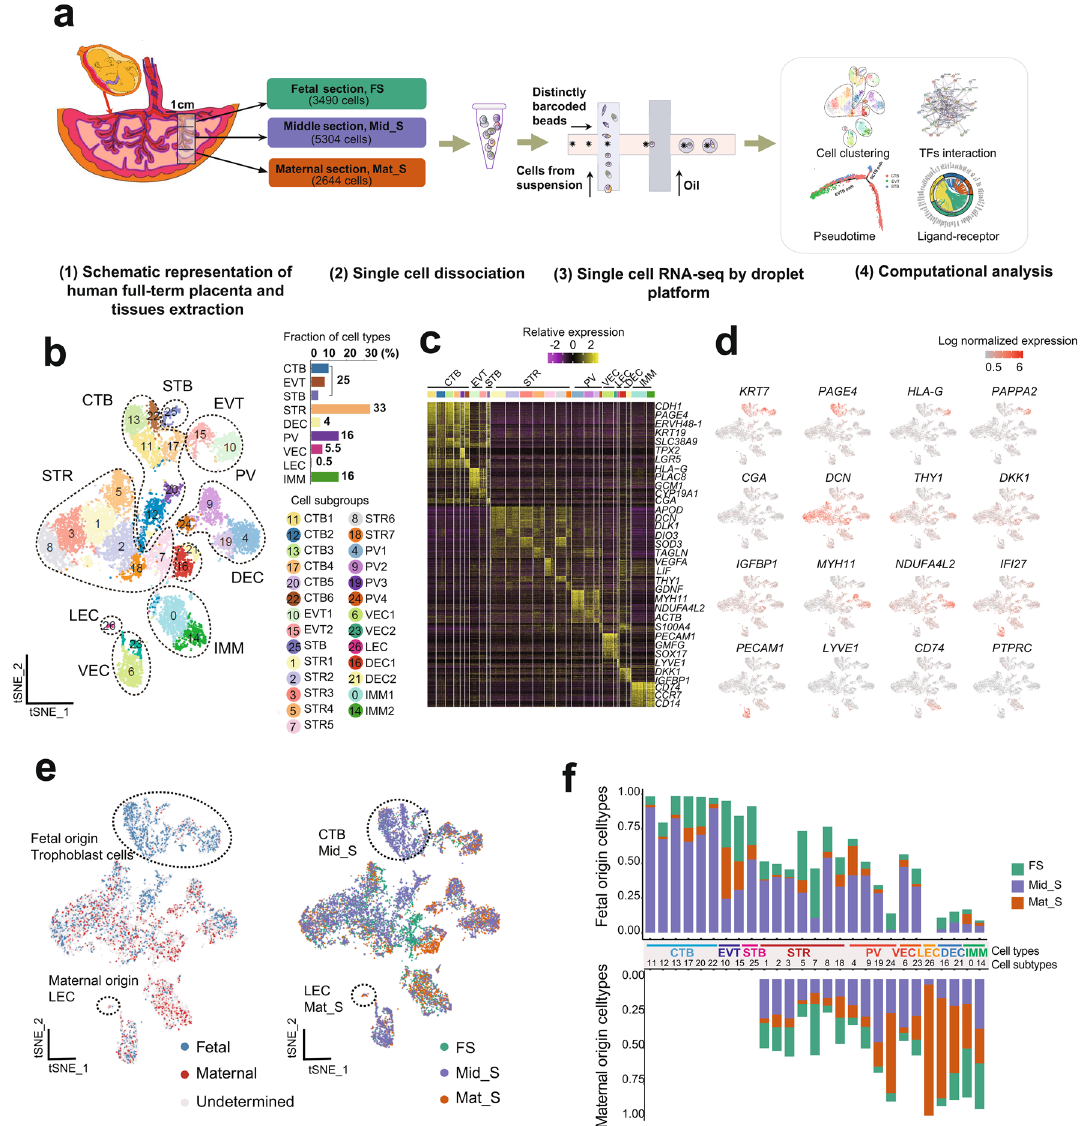
Figure 1. Dissecting cellular heterogeneity of human full-term placenta. ( a ) Workflow of single-cell transcriptome profiling of human full-term placenta. ( b ) T-distributed stochastic neighbor embedding (t-SNE) analysis of human full-term placenta (Left). Each dot represents an individual cell. Colors indicate cell type or state. PV, perivascular cell; STR, stromal cell; IMM, immune cell; CTB, villous cytotrophoblast; EVT, extravillous trophoblast; STB, syncytiotrophoblast; VEC, vascular endothelial cell; LEC, lymphatic endothlial cell; DEC, decidual cell. The column chart shows the fraction of indicated cell types (Right). ( c ) Heatmap showing the top differentially expressed genes of each cell cluster. Color scheme is based on relative gene expression (z-score). ( d ) t-SNE plot showing the gene expression pattern of selected cell type-specific markers in human placenta. ( e ) Origin (Left) and location (Right) of each cell is shown using the same layout as in ( b ). Circles mark cell types with relatively specific origin or spatial localization. ( f ) Column chart showing the percentage of indicated cell types from fetal or maternal origin in specific spatial location,